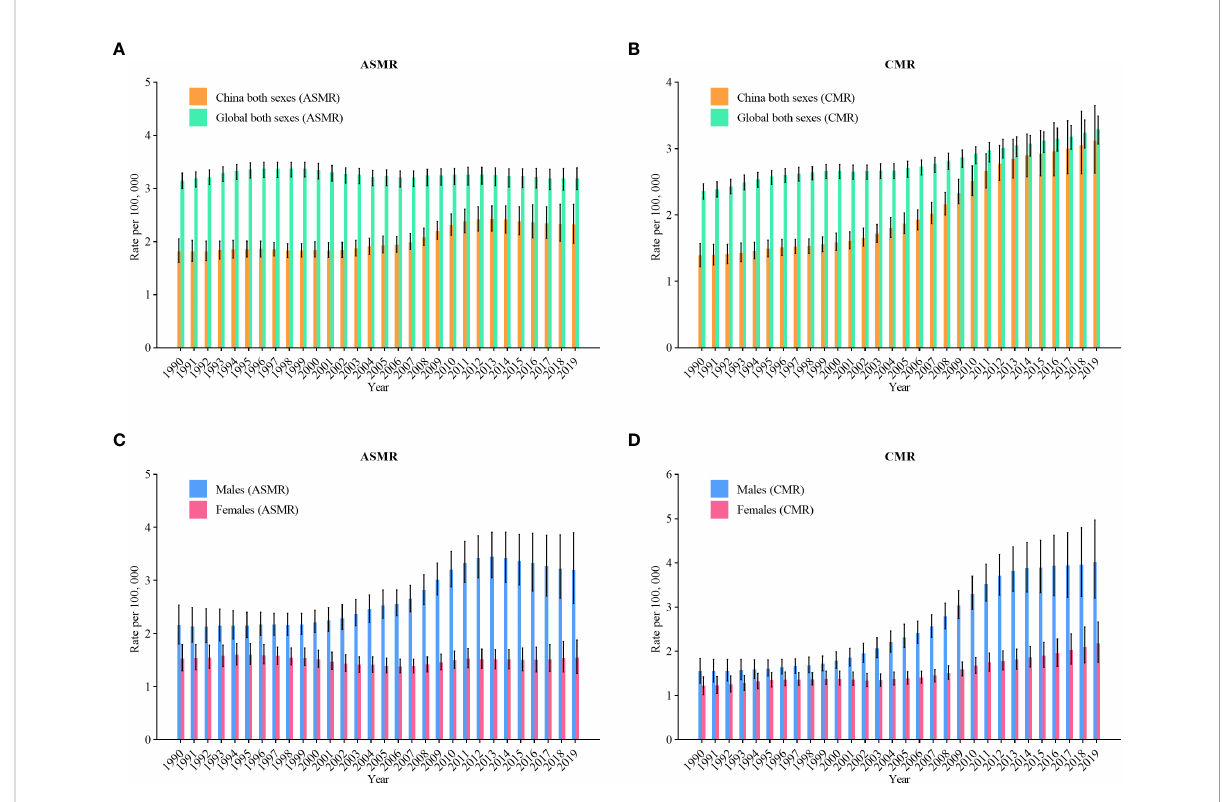
FIGURE 2 Trends in the age-standardized mortality rates (ASMR) and crude mortality rates(CMR) of non-Hodgkin lymphoma in China from 1990 to 2019. (A) ASMR for both genders; (B) CMR for both genders; (C) ASMR for males and females; (D) CMR for males and